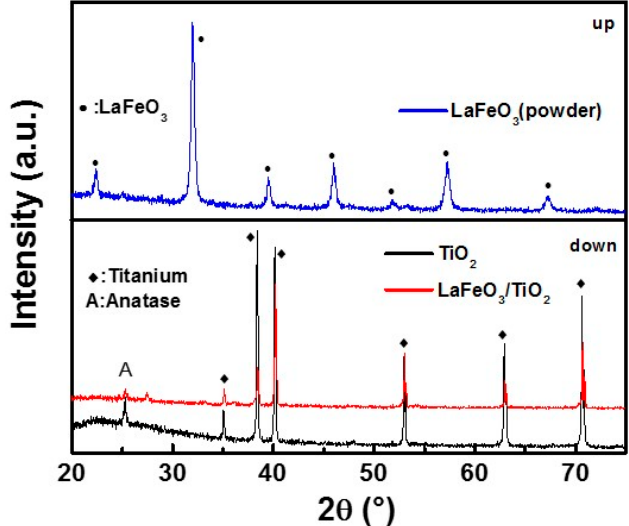
Figure 2. XRD patterns of TNTs, LFO/TNTs, and LaFeO 3 powders, respectively.